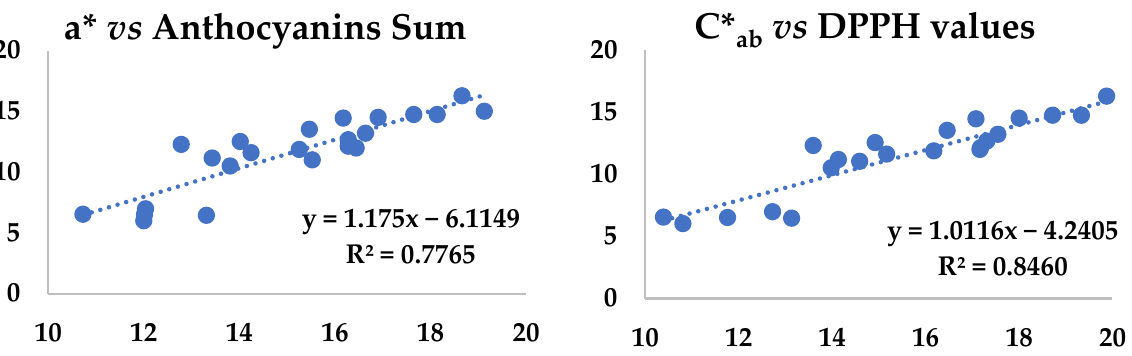
Figure 5. Correlation between a* and anthocyanin sum and between C* ab and DPPH values of different clusters. All values are reported as an average of the selected clusters (vintages 2019, 2020 and 2021; fresh and defrosted 2019, 2020 and 2021; M and U 2019, 2020 and 2021; fresh samples; defrosted samples; only homogenized samples; pasteurized samples; samples pasteurized before or after homogenization process).